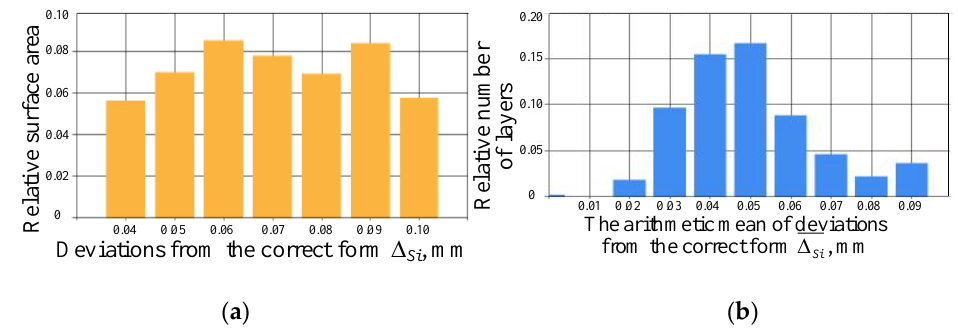
Figure 5. Densities of distribution of investigated characteristic of the layered building: ( a ) deviations from the correct form Δ S in the 8th layer; ( b ) arithmetic mean values Δ S over build layers.